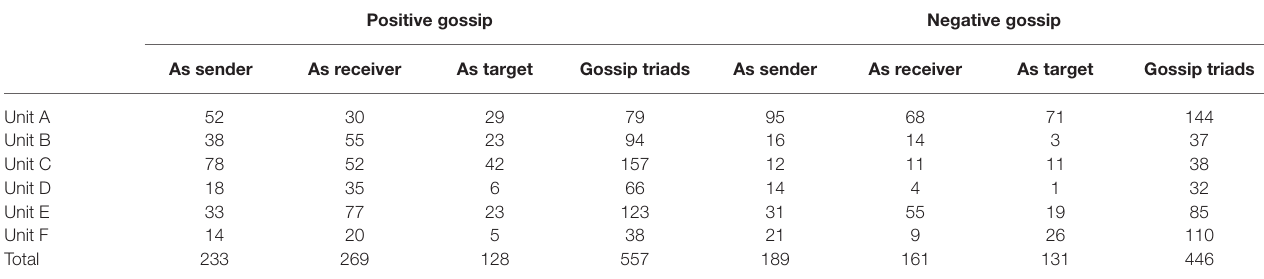
TABLE 2 | Involvement of brokers in the gossip triads.